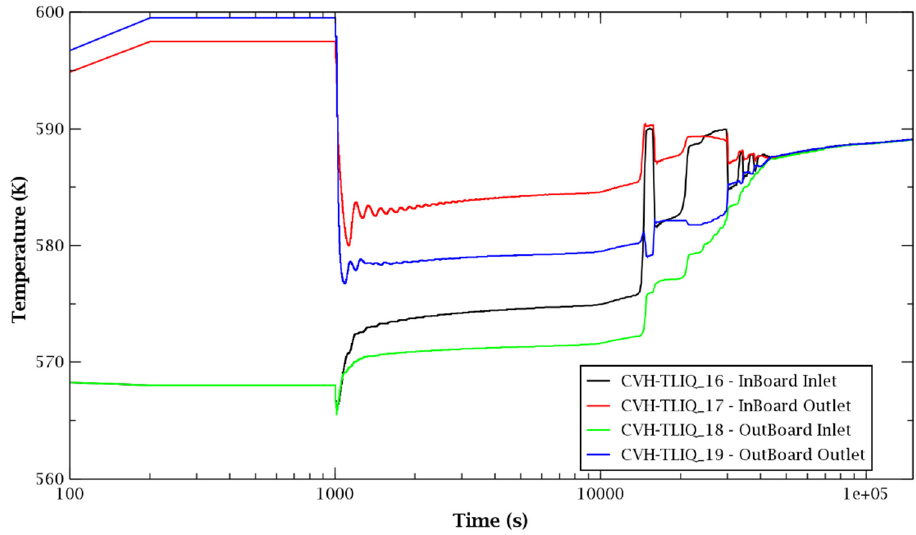
Figure 10. Temperature evolution in the BB: Case 3.